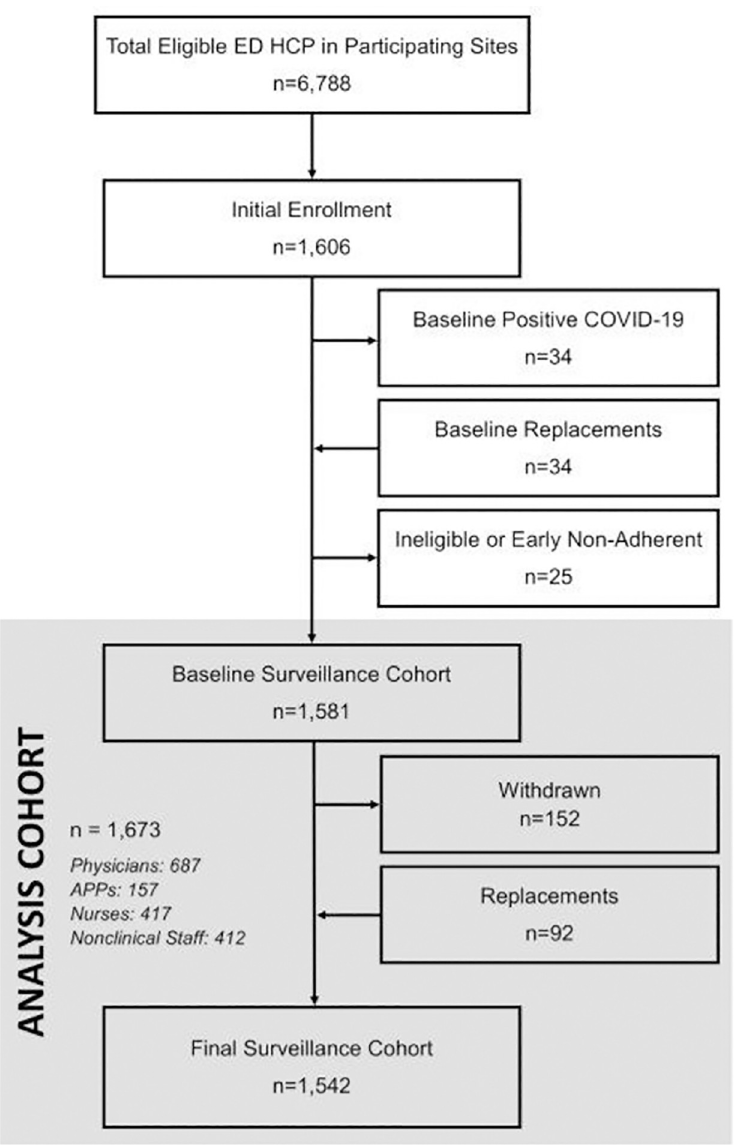
Fig 1. Screening and enrollment. The final analysis cohort had 1,673 participants who contributed 29,825 person- weeks of observation. Baseline Positive COVID-19 was defined as a positive reverse-transcription polymerase chain reaction (RT-PCR) or a positive SARS-CoV-2 anti-nucleocapsid IgG antibody, and any HCP with a positive baseline test was withdrawn and replaced in the surveillance cohort. ED , emergency department; HCP , health care personnel; APP , advanced practice provider